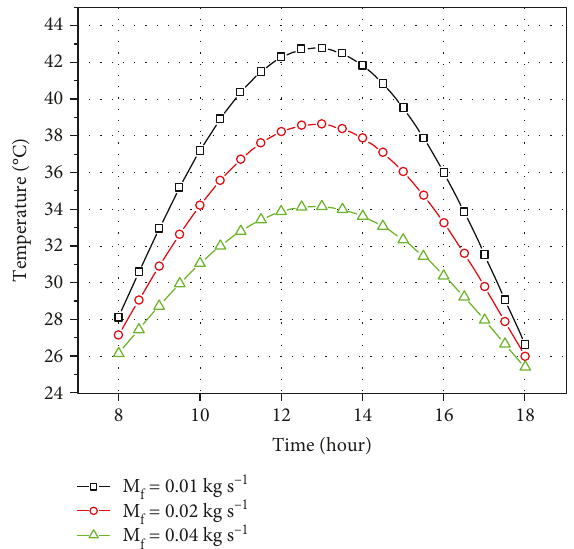
Figure 4: Hourly variation of the temperature of the fl uid.